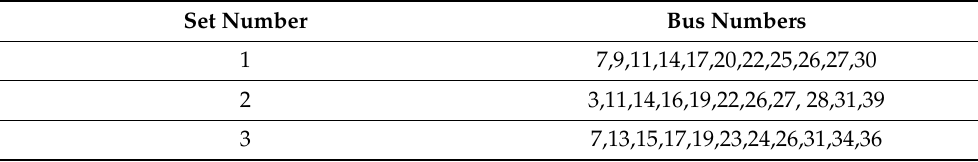
Table 2. Optimal Placement of measuring